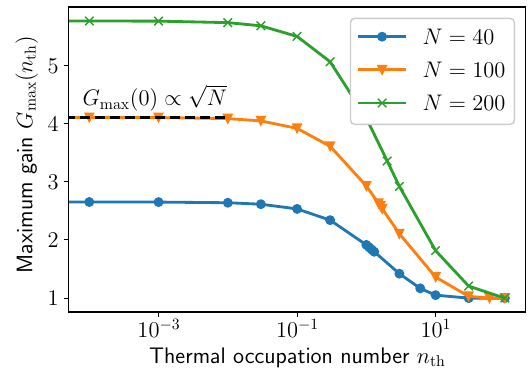
FIG. 6. The maximum gain in the presence of a nonzero ther- mal occupancy n th of the environment responsible for collective spin decay, obtained by numerically exact solution of the mas- ter equation (25). Each data point is obtained by maximizing the gain G ( t ) over the evolution time t . We see that a nonzero bath thermal occupancy rapidly degrades gain. At a heuristic level, the decay of the z polarization of the ensemble is seeded by both thermal and quantum bath fluctuations. Nonzero thermal fluctua- tions hence accelerate the decay, leading to a shorter time interval where the instantaneous gain rate λ( t ) is positive. This allows one to quantitatively understand the suppression of maximum gain seen here [see Eq.